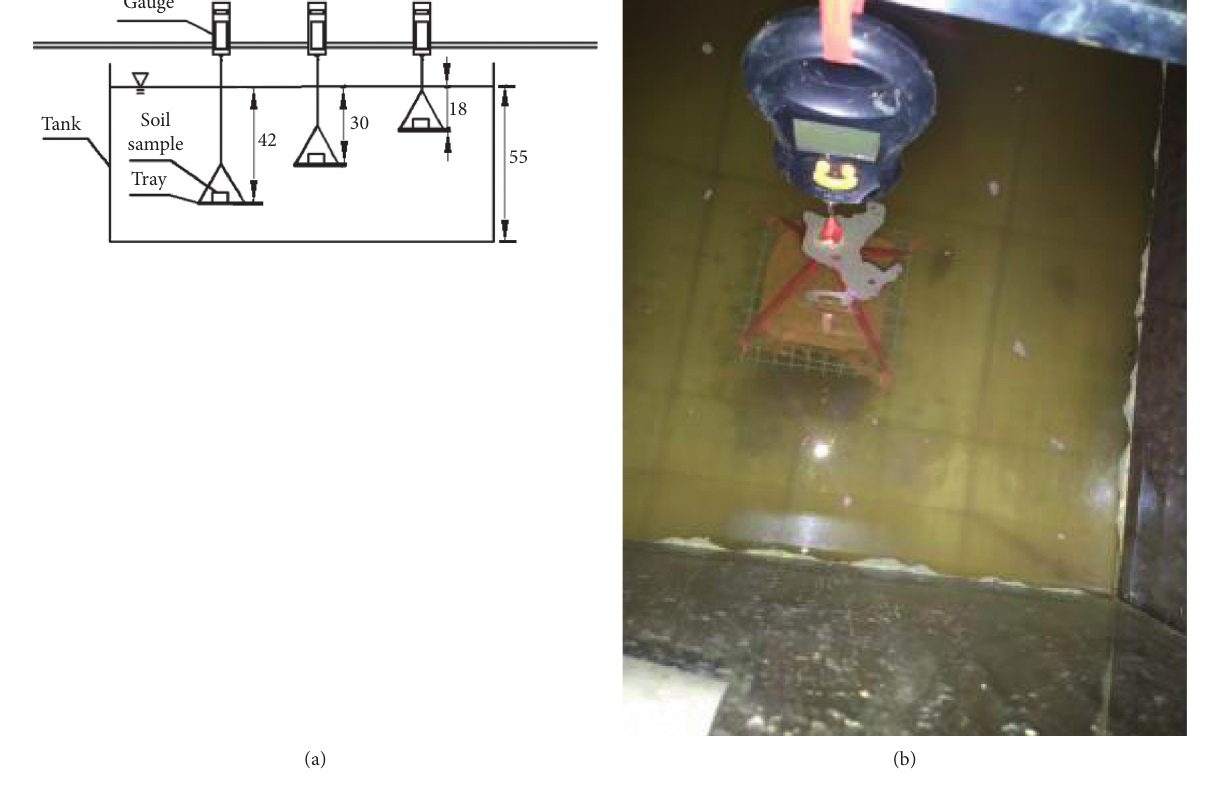
Figure 2: Model test system, (a) schematic diagram of test system (unit: cm), (b) test